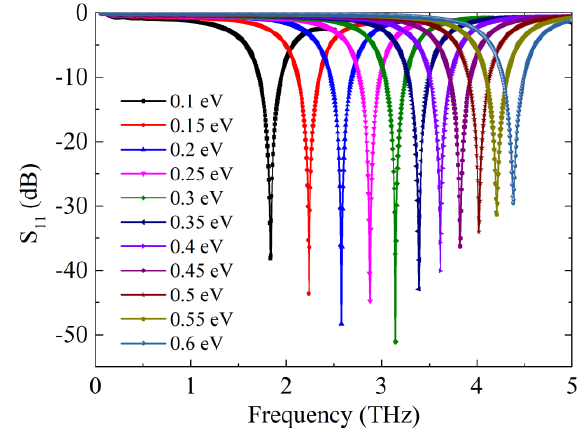
Figure 2. Simulated reflection coefficient with chemical potential levels from 0.1 eV to 0.6 eV. The relaxation time is 0.5 ps and the temperature is 300 K.